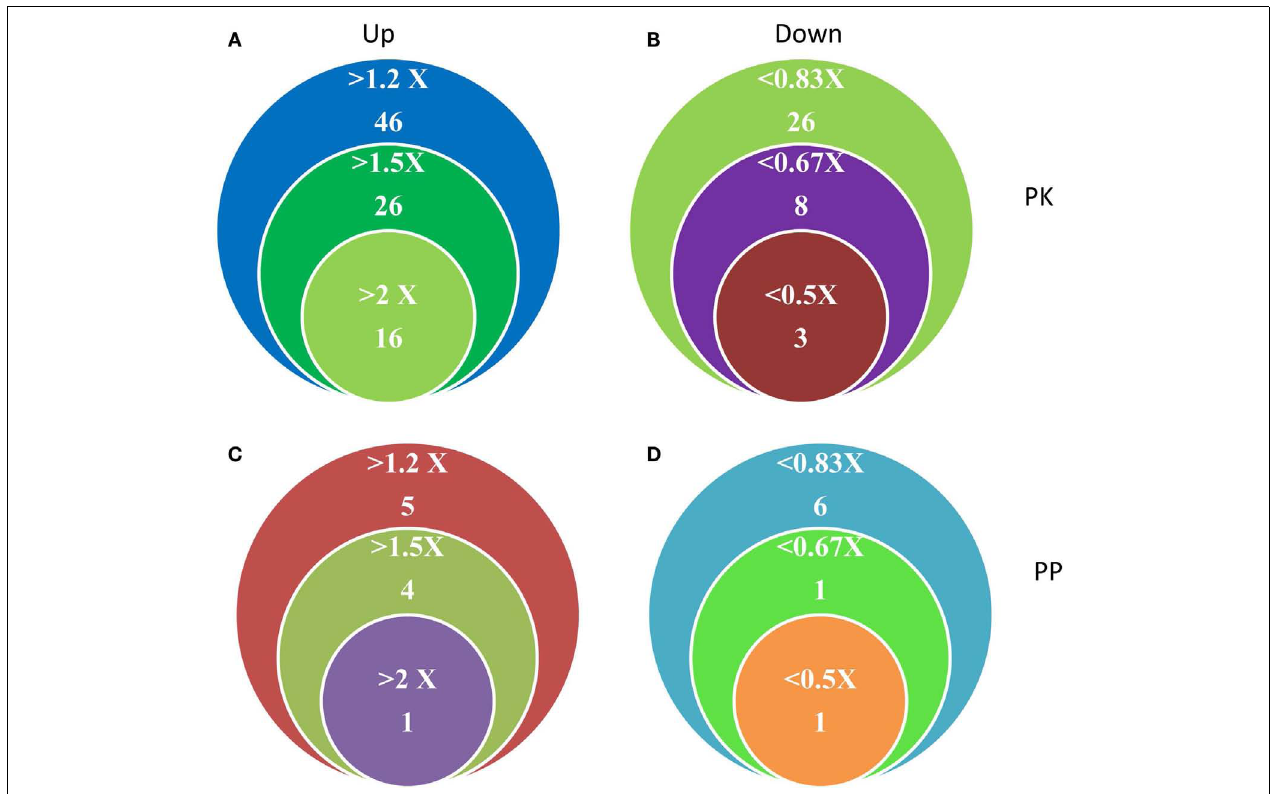
FIGURE 2 | Differentially expressed PK and PP genes in Fe-deficient Arabidopsis roots . (A,B) Number and expression levels of PK genes. (C,D) Number and expression levels of PP genes.